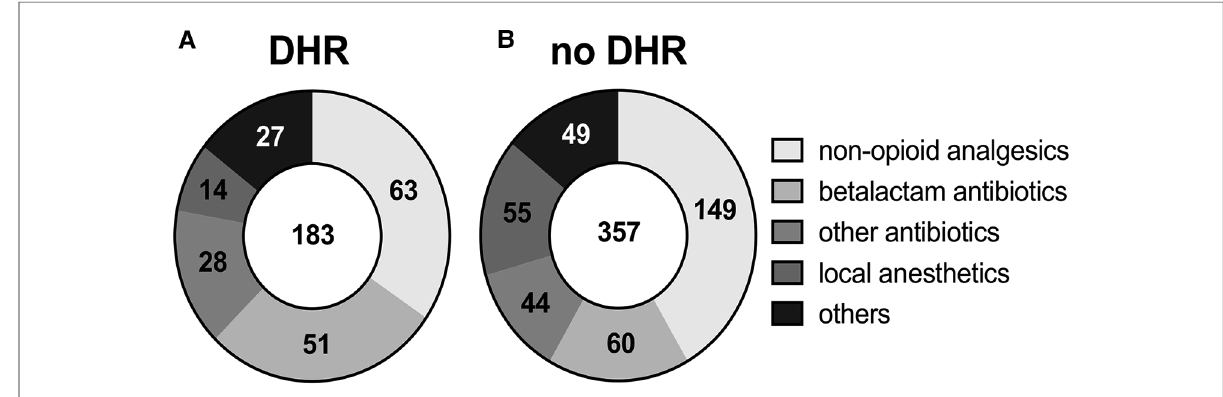
FIGURE 1 Drug classes in drug hypersensitivity. Diagrams depict the proportion of drug classes and number of cases of ( A ) con fi rmed and ( B ) excluded